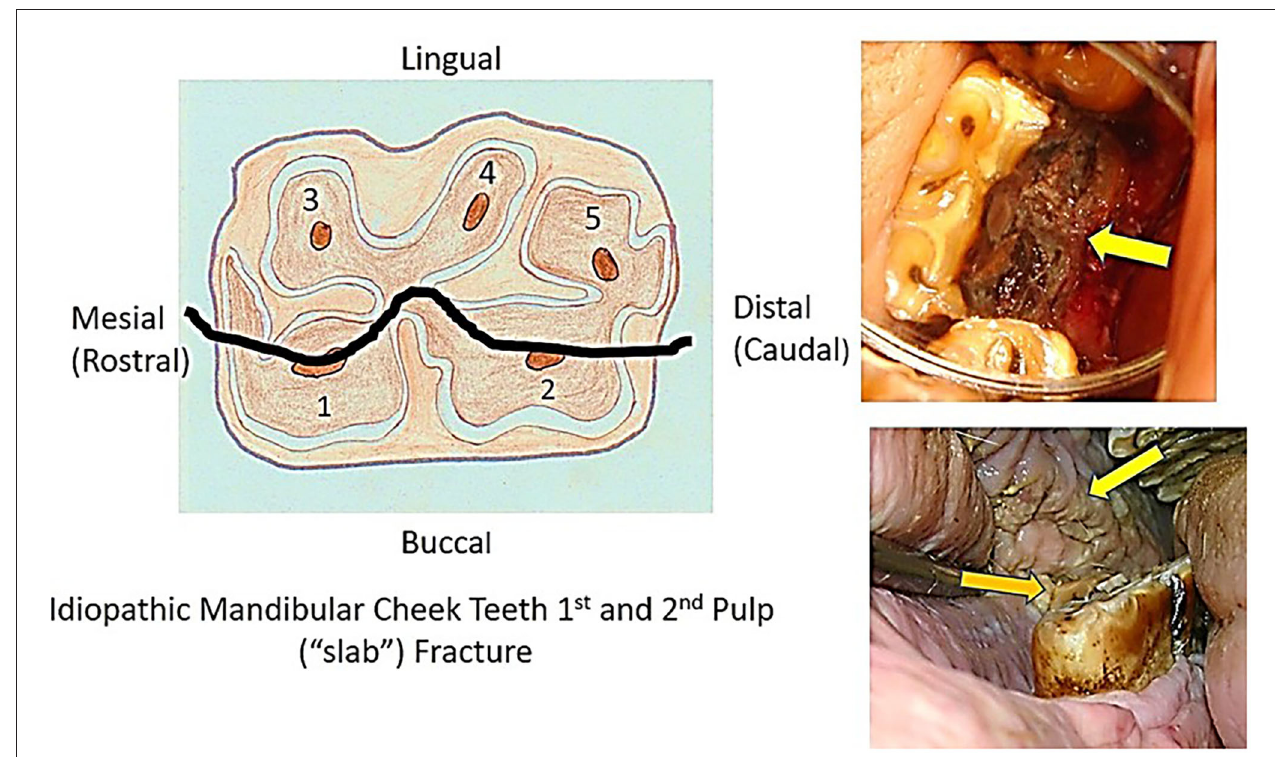
FIGURE 4 | The diagram on the left shows the mandibular cheek teeth pulp horn positions and the site of a fracture plane through pulp horns 1 and 2 (“slab” fracture). The top right image shows a left mandibular cheek tooth with a first and second pulp horn fracture and loss of the buccal fragment (arrow) and slight lingual displacement of the remaining tooth. The bottom right image shows a displaced buccal fragment of a “slab” fracture (bottom arrow) that has caused marked, chronic buccal trauma (top